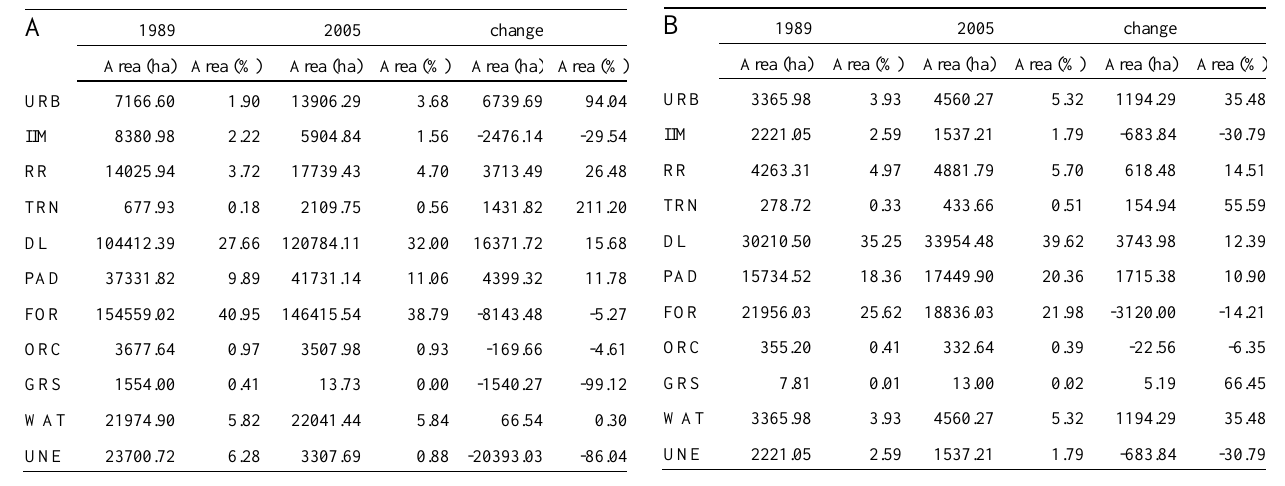
Table 1. Land use in the metropolitan area of Jilin City between 1989 and 2005 (A: the total metropolitan area; B: Changyi district; C: Chuangying district; D: Fengman district; E: Longtan